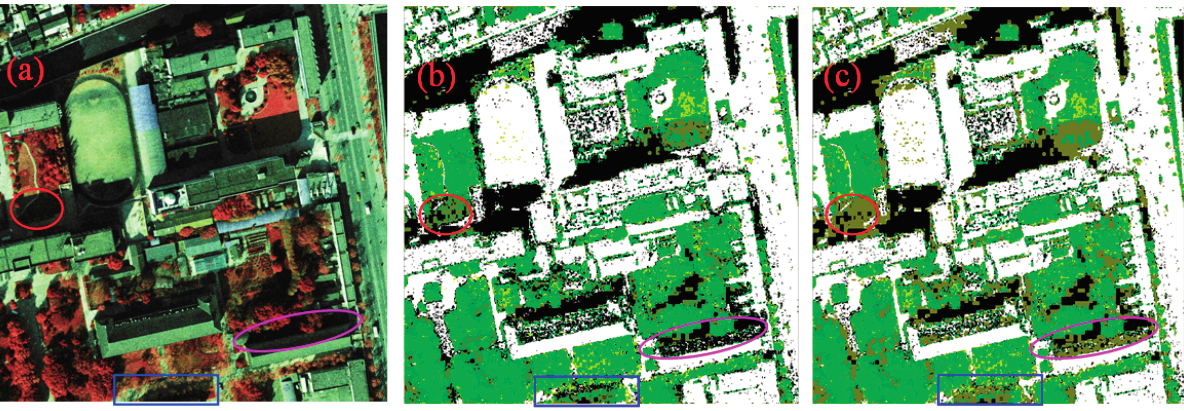
Figure 3. An example of classification in the feature space of NDVI , NDSV , C , D , D d ds dm where D , D are of two cases of D involved with the dark details of small and and D e ds dm d middle sizes, respectively. ( a) The original image; ( b ) the members classified in the feature space including D ; and ( c ) the members classified without using D . It can be seen that e e shaded tree and dark background members, if without D , are often mistaken for shaded e grass (e.g., those in the elliptical and rectangular regions of different colors) but . The test-site locates at sub-site 3 (See Figure significantly improved by adding D e